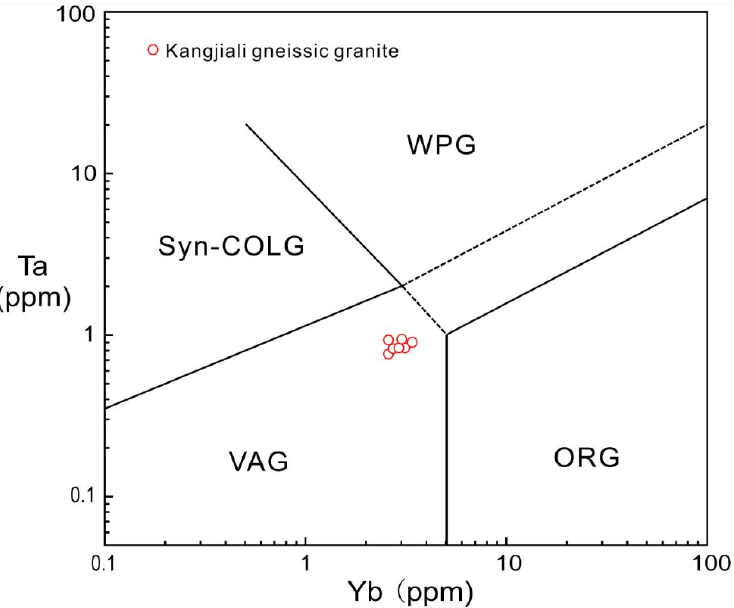
Figure 13. (Yb + Ta) versus Rb diagram and Yb versus Ta diagram [32] of the Kangjiali gneissic granite.